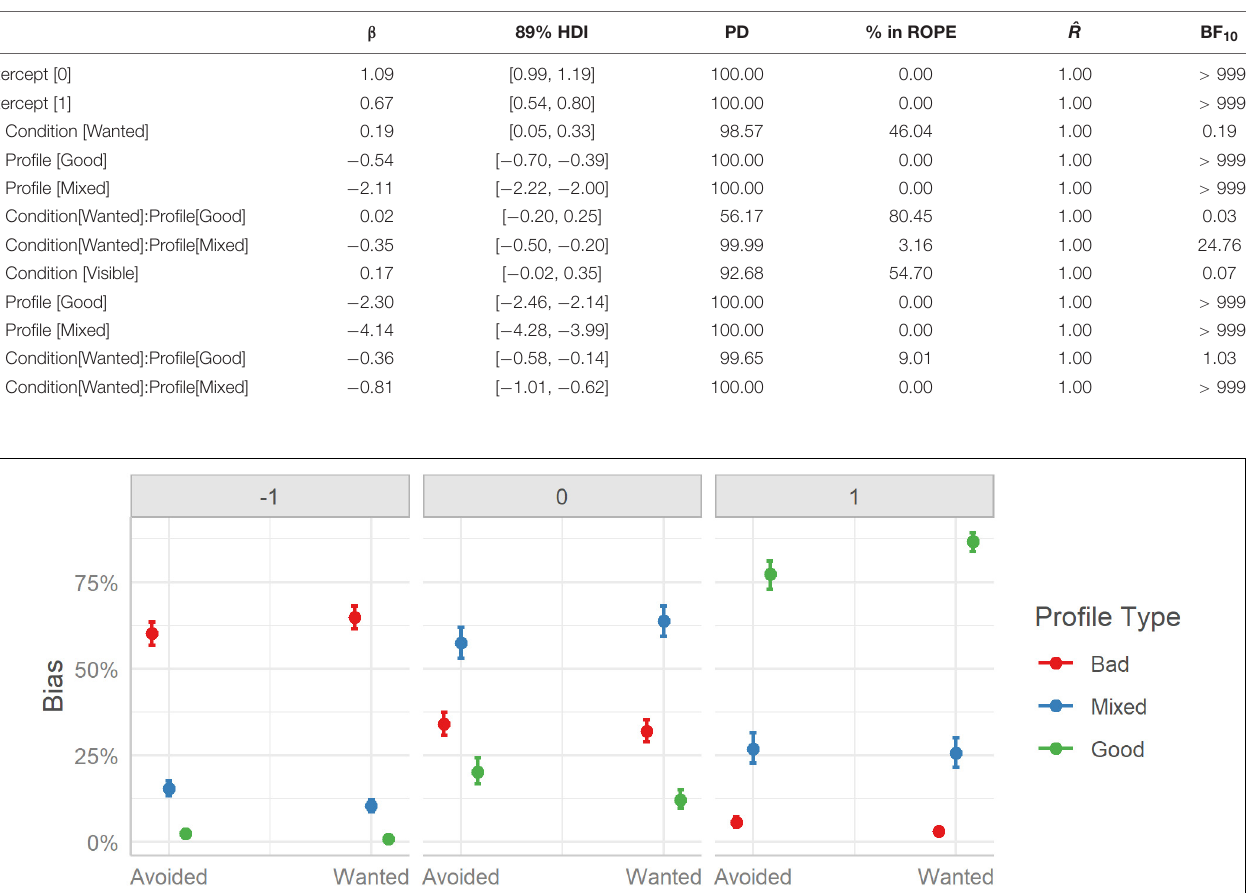
TABLE 11 | Summary of the model fitted to the bias data, considering the experimental condition (Wanted or Avoided) and Profile type (Good, Mixed, and Bad).